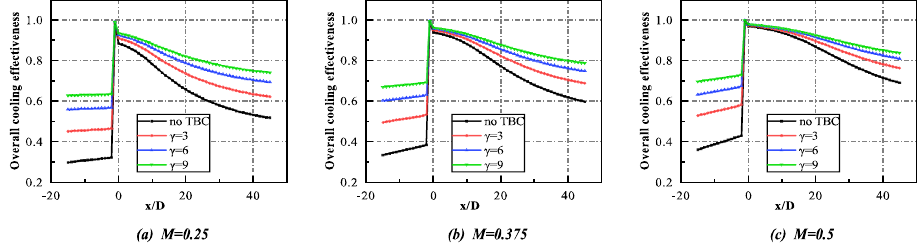
(cid:0) (cid:1) m 2 · K .